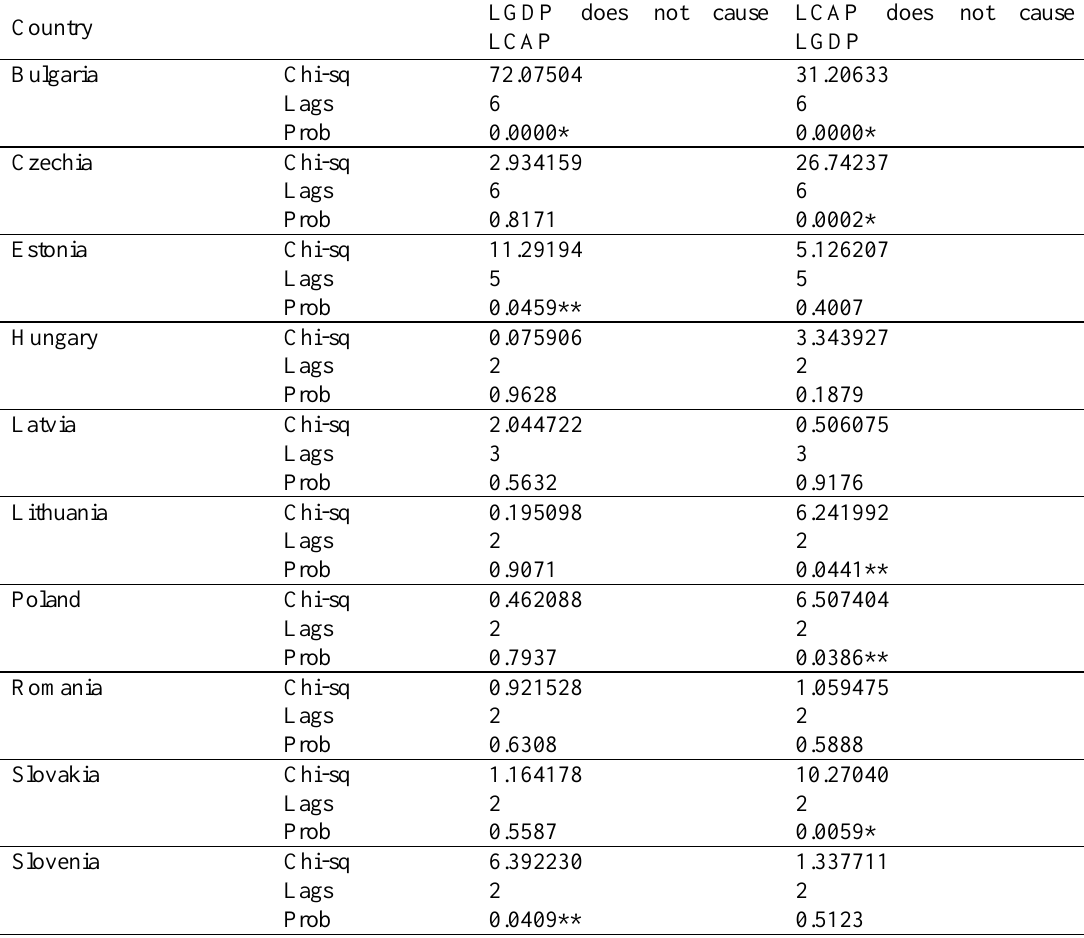
Table 6. Causality from the Toda-Yamamoto approach